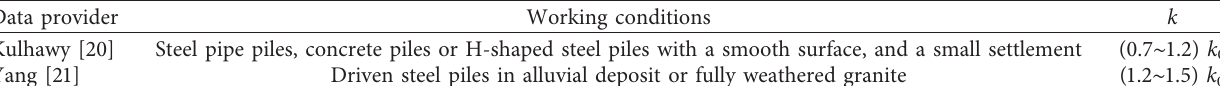
Table 1: Suggested value of the lateral earth pressure coefficient k .